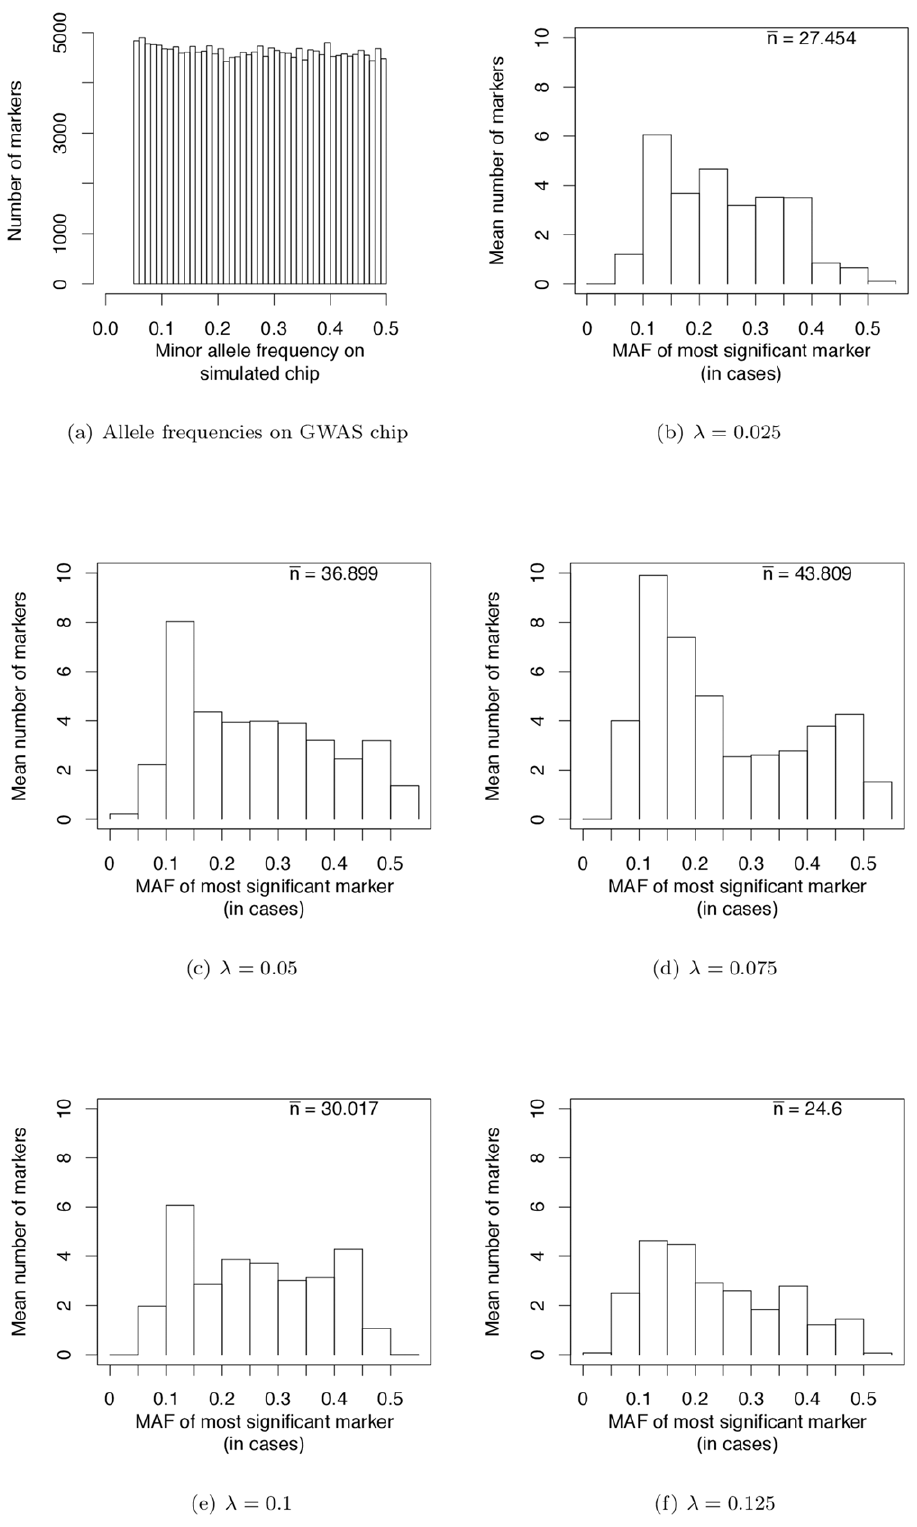
Figure 4. Frequencies of most significant markers (based on the logistic regression test) in GWAS based on genotyping panels of previously ascertained SNPs. (a) From our simulated case-control studies, we randomly-sampled markers in order to mimic the ascertainment of common markers typical of current GWAS, which resulted in a uniform distribution of minor allele frequencies. The distribution shown here is summed across all replicate simulations of a gene region. (b–f) Monte Carlo estimates of the expected number of most-associated markers in different frequency intervals for different values of l (the mean effect size of a causative mutation). The x-axis represent the frequency of the minor